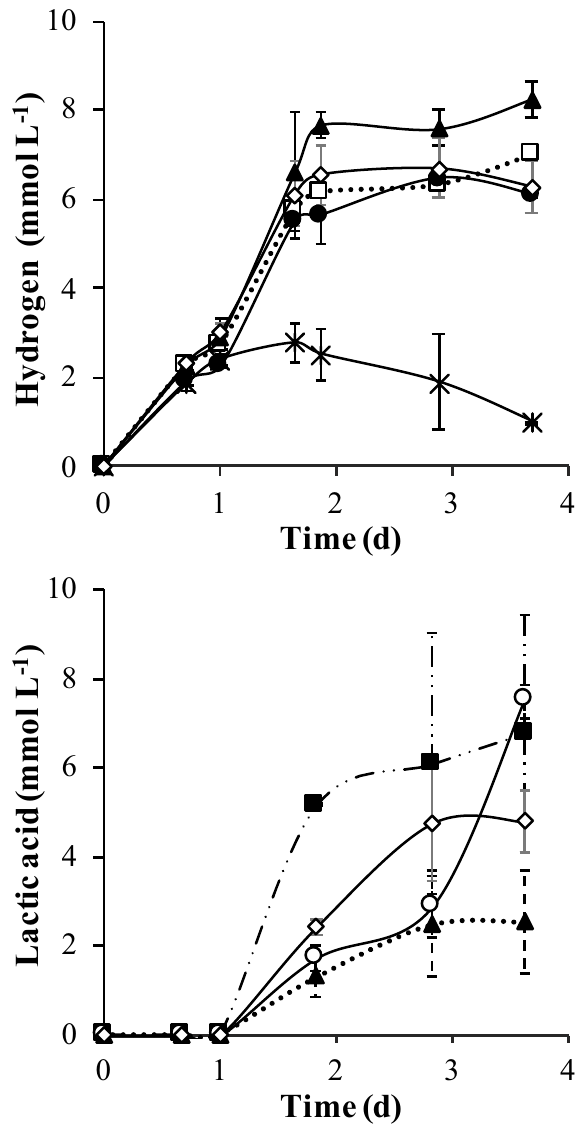
Figure 5. Cumulative hydrogen production for the Z/I ratio of ……. 0.26 g g −1 , …… 0.13 g g −1 , 0.065 g g −1 , and for the …… control, and respectively lactic acid production for the Z/I ratio of ………. 0.26 g g −1 ; …… 0.13 g g −1 , 0.065 g g −1 and for the ……. control. …… Blank assay without zeolite and Sargassum sp. The results are the average and standard deviations for duplicate assays.